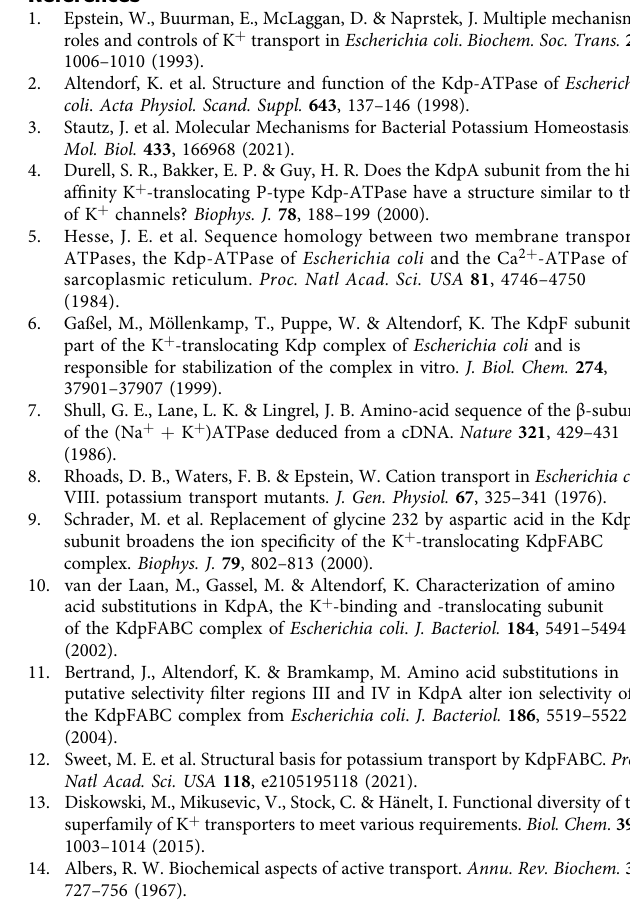
Figure preparation . Figures were prepared using UCSF Chimera 65 , UCSF ChimeraX 91 , PyMOL, VMD 86 , OriginPro 2016, and GraphPad Prism 8. Data